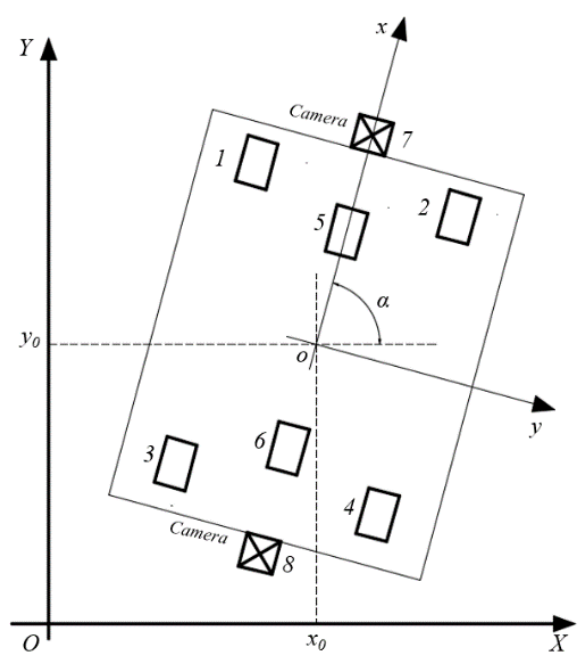
Figure 5. Global and local coordinate systems.